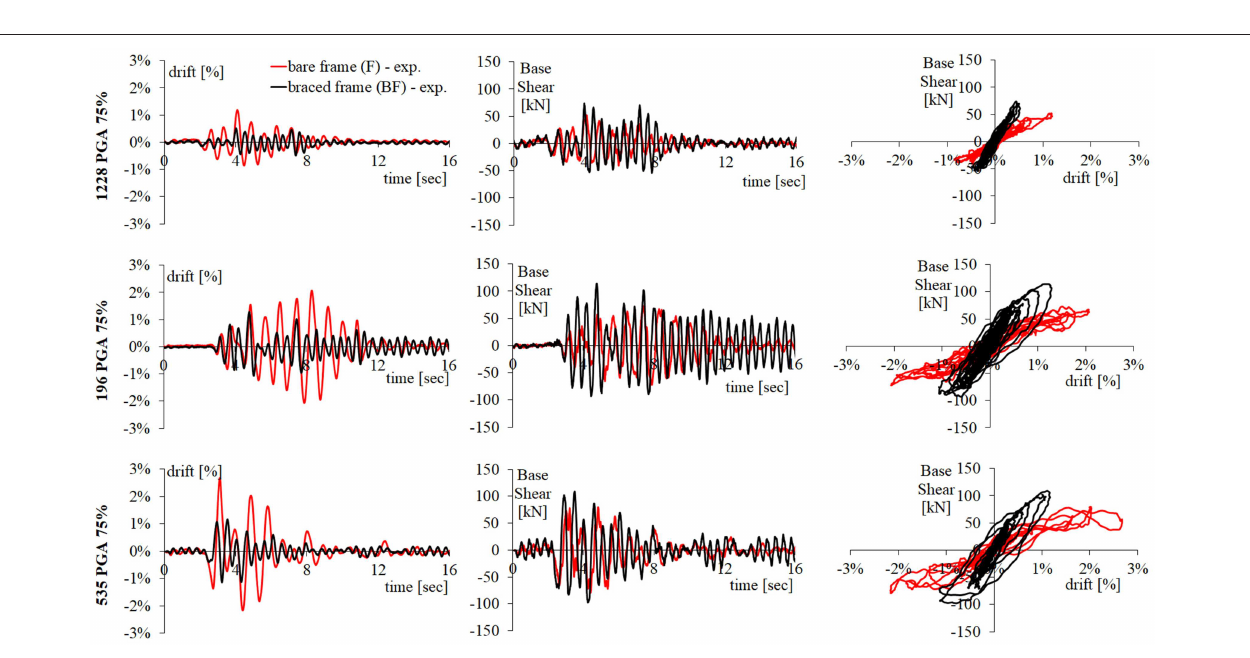
Frontiers in Built Environment | www.frontiersin.org